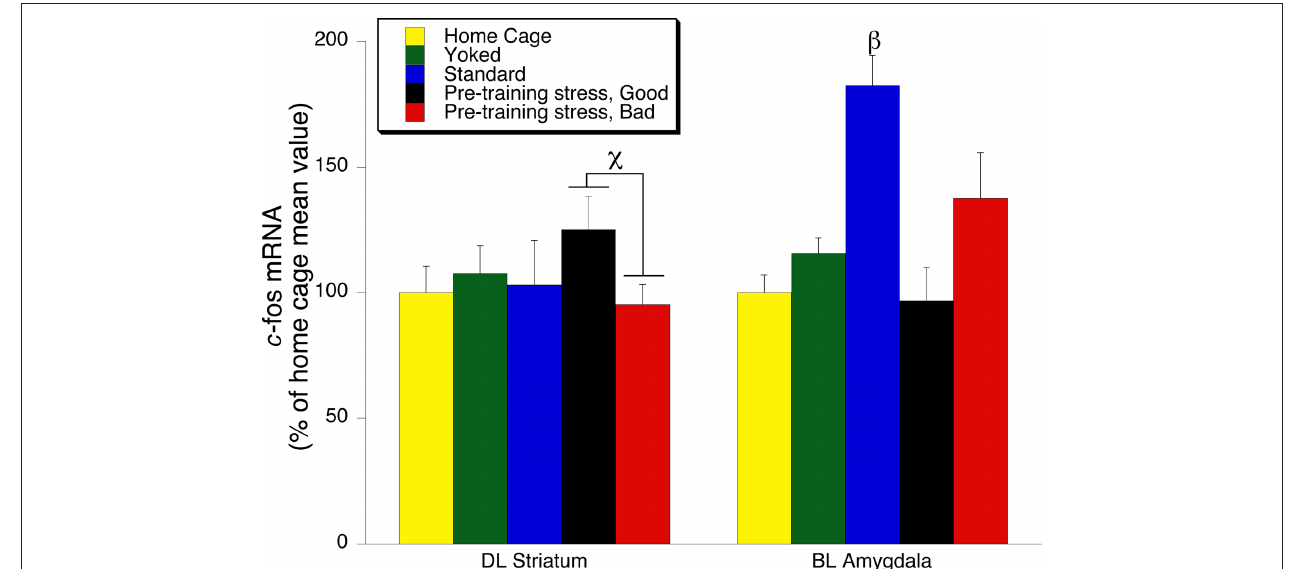
mRNA in the Basolateral (BL) amygdala in the Standard trained group compared to all other groups ( p < 0.05, SNK post hoc test). The data from the DL and BLA and were obtained from tissue samples which were assayed in different in situ films. Therefore, the data were normalized to responses within each region, and expressed as a percent of the home cage response for each